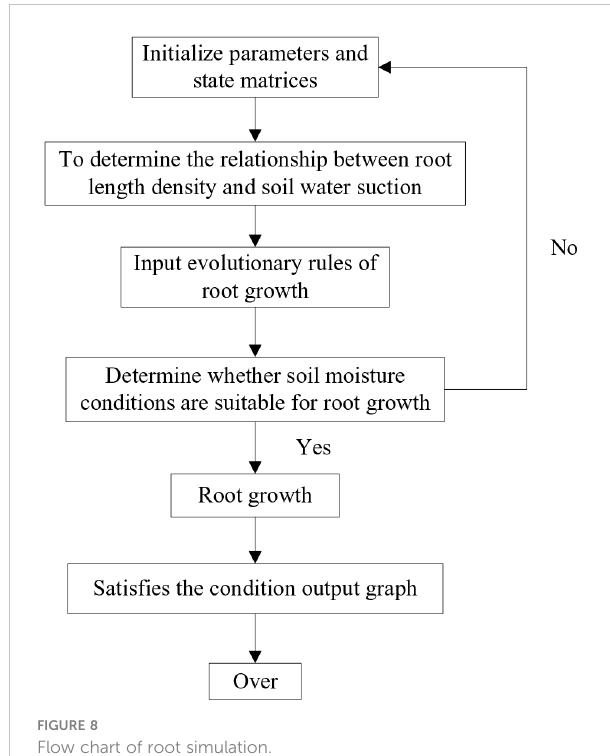
FIGURE 8 Flow chart of root